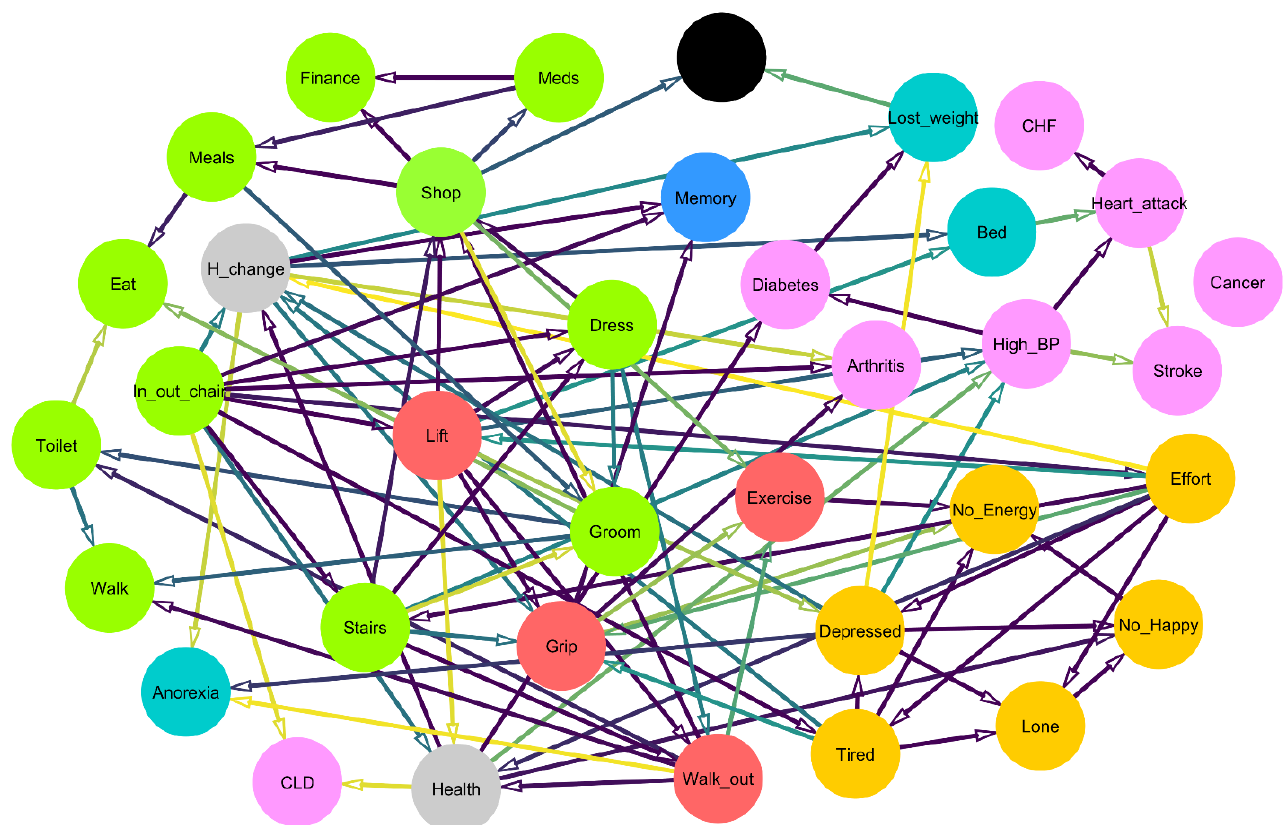
Figure 1. Averaged Bayesian network associated with frailty components and the dead node con- sidering a bootstrap sample of 100, using a hc algorithm with BIC score for each sample. Nodes are colored according to the following classification: black: Dead ; yellow: AS (Affective Status: No_Happy, Lone, No energy, Depressed, Tired, and Effort ); light blue: symptoms ( Anorexia, Bed, and Lost_weight ); gray: SRH ( Self-rated health: Health and H_change ); green: ADL-IADL (activities of daily living and instrumental activities of daily living: In_out_chair, Stairs, Shop, Dress, Walk, Eat, Groom, Meals, Meds, Finance, and Toilet ); orange: physical health ( Grip, Exercise, Lift, and Walk_out ); pink: comorbidities ( CLD, Stroke, Cancer, CHF, Arthritis, Heart_Attack, Diabetes, and High_BP ); navy blue: cognition ( Memory ). A color scale distributes edge colors according to strength of the relationship between the variables: yellow – green – purple (from 0.5 to 1.0, respectively).